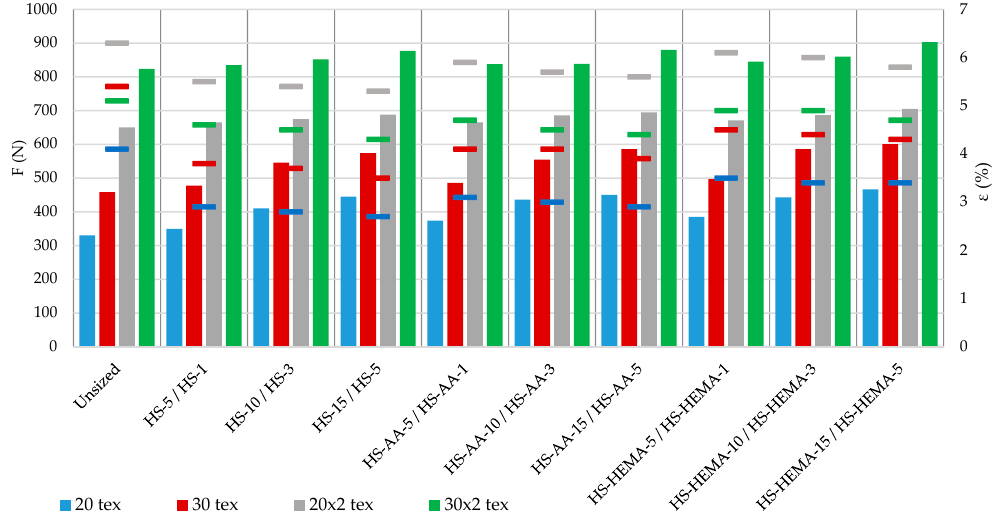
Figure 9. Breaking forces and elongation at break of the yarn.